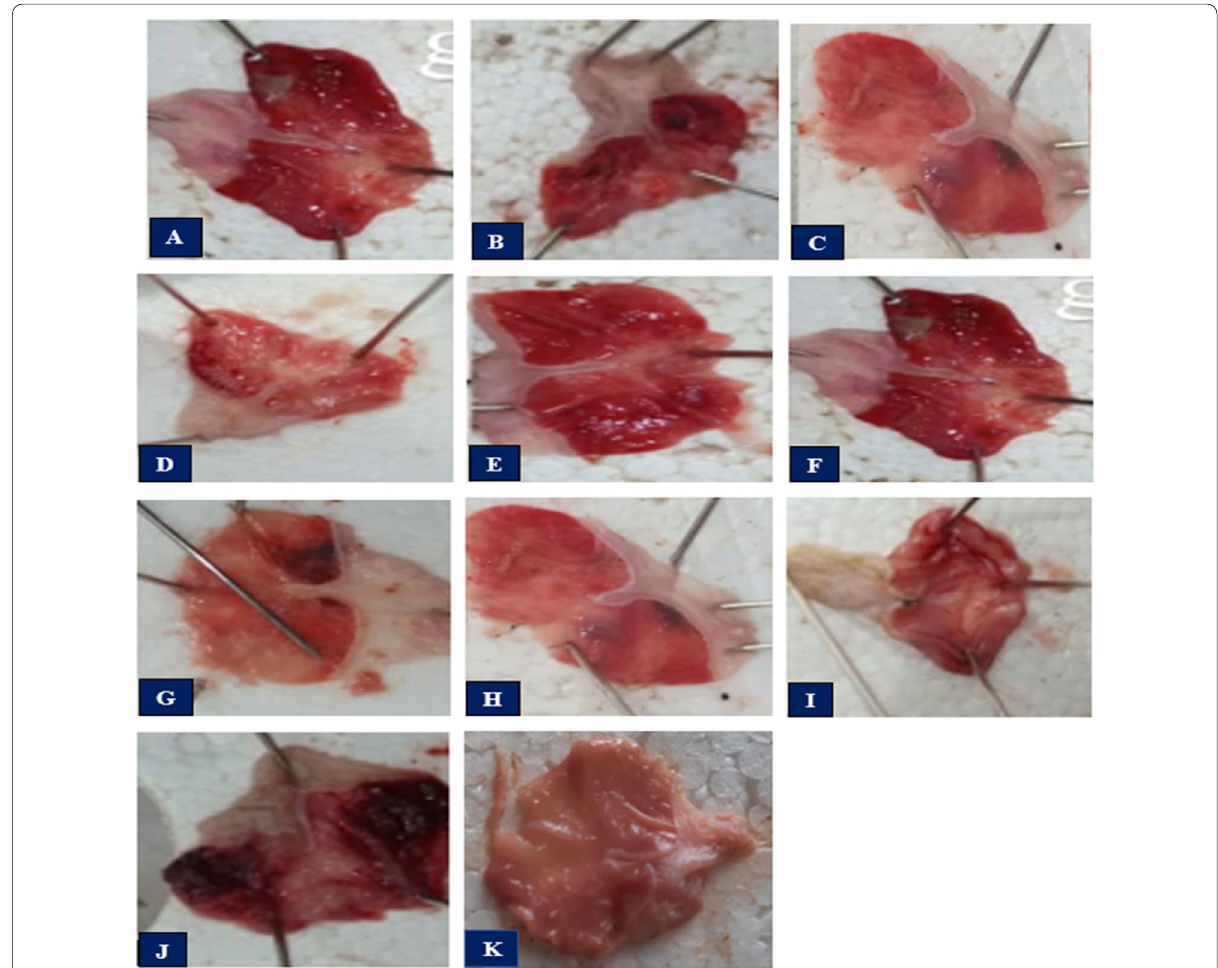
Fig. 1 Effects of C. paniculatum extract and its fractions on gross lesions induced by absolute ethanol. MECP 100, 200 mg/kg ( A , B ); HFCP